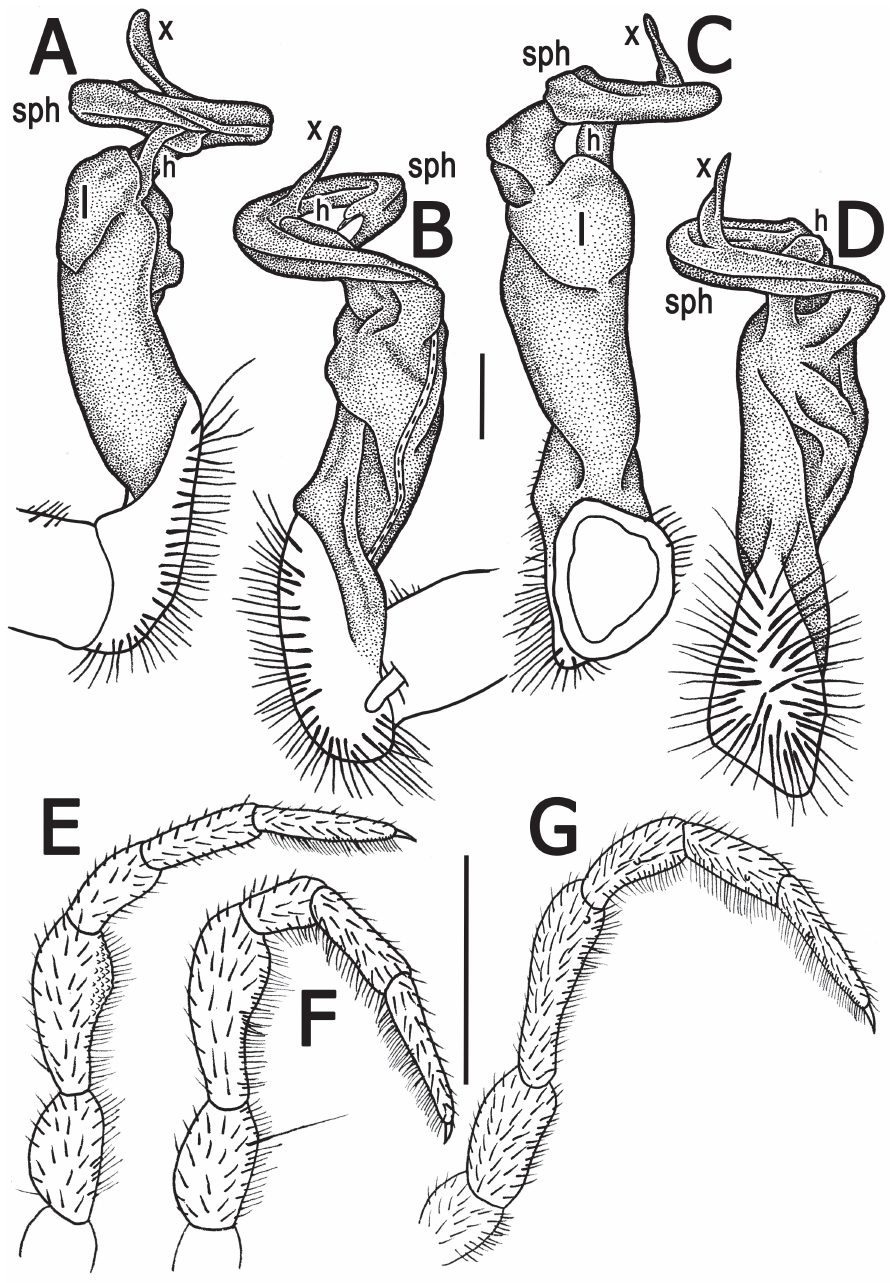
Fig. 17. Tylopus dorsalis sp. nov., holotype, ♂. A–D . right gonopod, lateral, mesal, caudal and oral views, respectively. Scale bars = 0.2 mm. abbreviations are explained in the